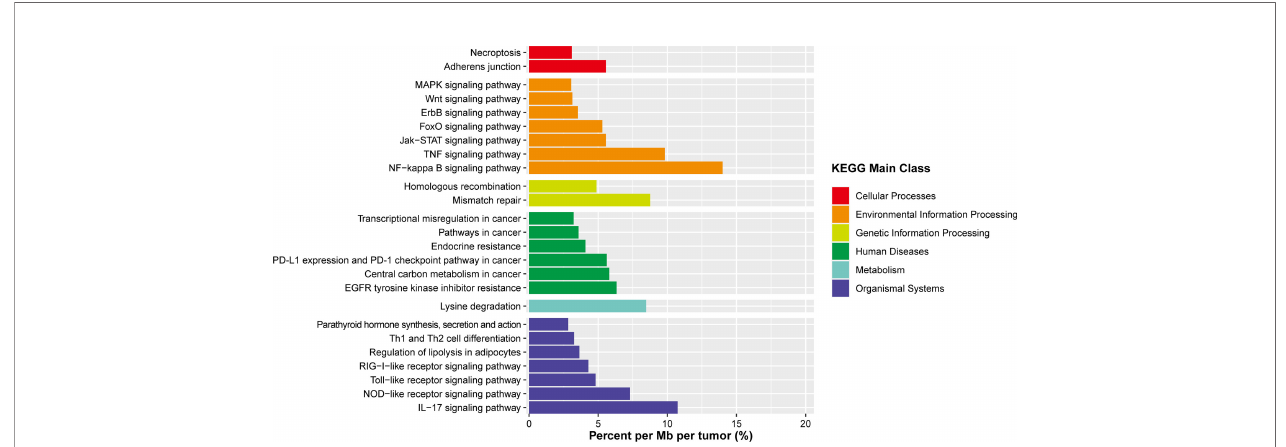
FIGURE 6 | Summary of signaling pathways affected by frequent somatic mutations in OAML. In addition to the common mutations reported, several novel mutations are described, affecting de fi ned biological pathways. Mutation rates were calculated by dividing the total number of mutations encountered in a pathway by the number of all genes belonging to that pathway and the size of the coding tumors